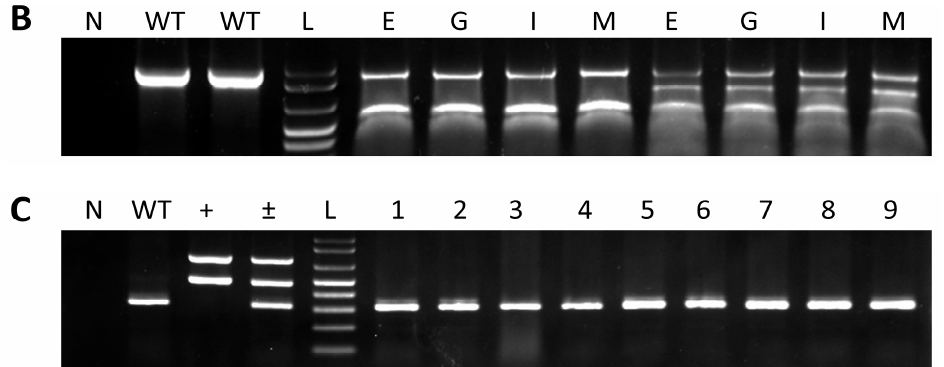
Figure 2. Identification of mutated melanocortin-4 receptor ( mc4r ) gene and integration of sgRNA and Cas9 plasmids in channel catfish, Ictalurus punctatus . N indicates the no-template control, while the WT lane represents samples from wild-type channel catfish. L indicates 1 kb plus DNA ladder (Invitrogen). ( A ) Surveyor-based detection of mc4r gene mutations in pelvic fins from 10 channel catfish. Letters and numbers represent channel catfish tested from different treatments; E1, E2 (electroporated treatment); A1, A2 (MC4RA treatment); B1, B2 (MC4RB treatment); C1, C2 (MC4RC treatment); X1, X2 (MC4RMIX treatment). The presence of two or more additional bands compared to the WT lane indicates the occurrence of mutations. ( B ) Surveyor-based detection of mc4r gene mutations in different tissues from two mutated channel catfish. E, eye; G, gills; I, intestine; M, muscle. ( C ) Integration of Cas9 and sgRNA plasmids in electroporated fish. The plus sign (+) indicates the positive controls (Cas9 and sgRNA plasmids). The plus/minus sign (±) indicates the positive controls and wild-type channel catfish. Numbers represent channel catfish individuals carrying mutated mc4r gene.